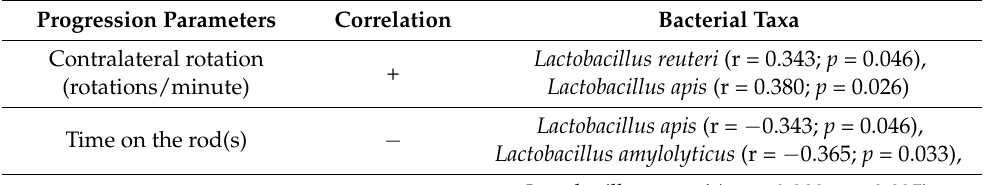
Table 3. Correlations between the taxa abundance of bacterial species and parameters of Parkinson’s disease